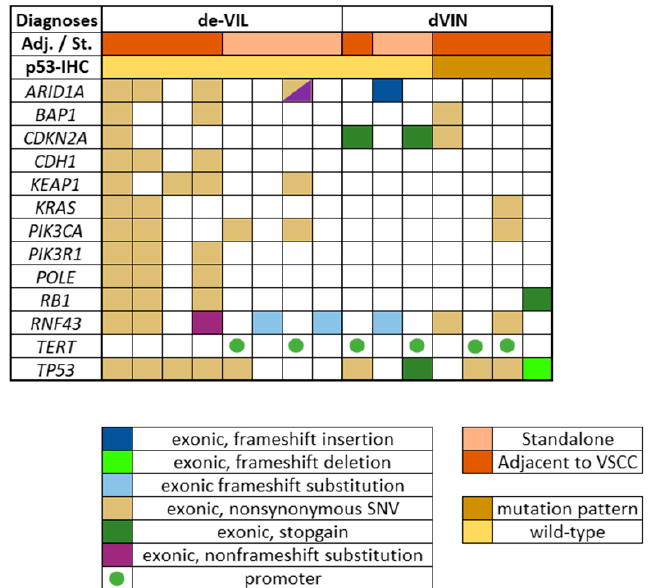
Figure 6. Pathogenic somatic mutations detected in at least 3 samples of de-VIL and dVIN; color- coding represents the types of mutations, p53-immunohistochemistry (IHC) results, and whether the lesion was standalone or present in tissue adjacent to vulvar squamous cell carcinoma (VSCC);